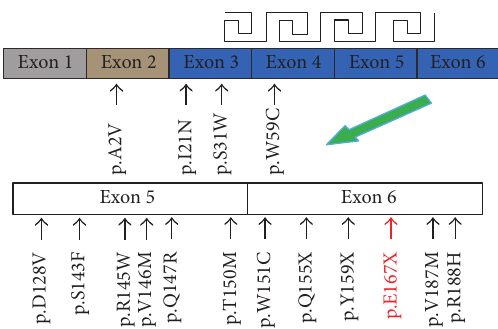
Figure 4: Schematic overview of gene structure and missense muta- tionsfound in CRYBB2 . The CRYBB2 gene consistsof six exons; each of the exons (exon 3 to exon 6) encodes one Greek key motif. The mutation identified in this study is highlighted in